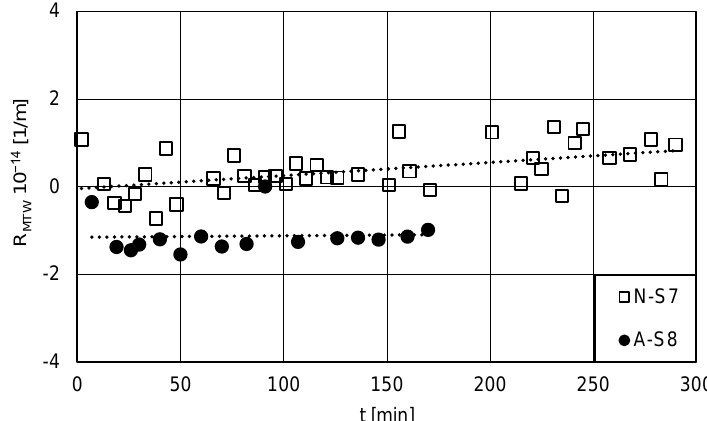
Figure 8. Permeate flux vs. time during the RO process conducted using the AG Osmonics mem- brane and the MTW containing an anionic (A-S8) or a nonionic agent (N-S7).